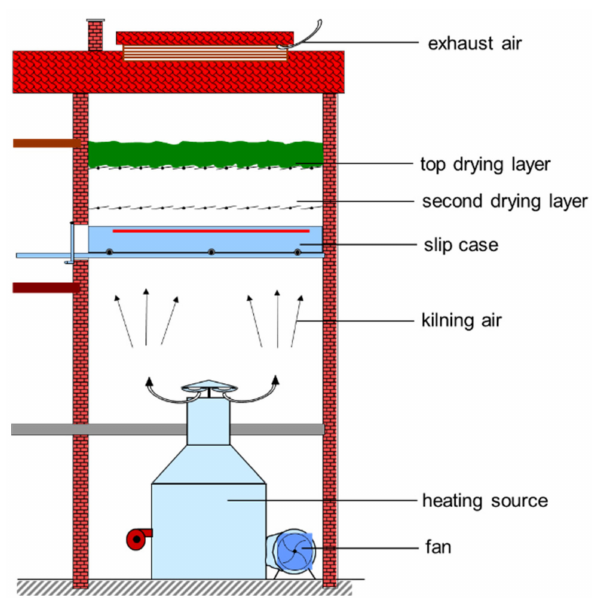
Figure 1. Schematic of hops dryer (adapted and revised from [9]).